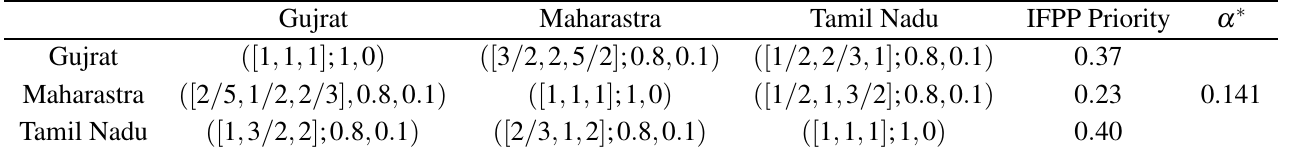
Table 6: Generalized intuitionistic fuzzy pair-wise comparison matrix with respect to EN Gujrat Maharastra